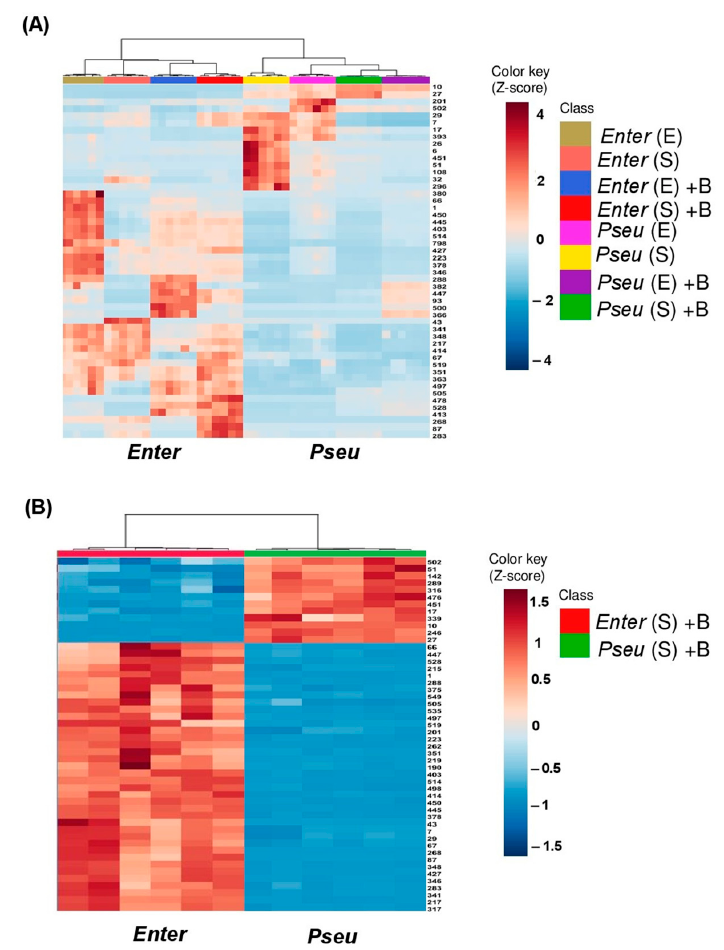
Figure 6. Heat map describing the distribution of the top 50 more discriminant metabolites, between BPMP-PU-28 ( Pseudomonas urmiensis ) and BPMP-EL-40 ( Enterobacter ludwigii ), according to culture conditions and growth stages. Pseu ( Pseudomonas urmiensis ) and Enter ( Enterobacter ludwigii ) were grown in minimal Hoagland medium supplemented with lactate (2%) (see Figure S5) and buffered (150 mM KH 2 PO 4 /K 2 HPO 4 , pH 6.7) (B) or unbuffered (U). Aliquots of culture supernatant were collected during the exponential and stationary phases (E and S, respectively; see arrows in Figure S5) and analyzed by LC-MS/MS. The heat map was generated by MetaboAnalyst 5.0 28 (https:// www.metaboanalyst.ca/MetaboAnalyst/ModuleView.xhtml) accessed on 15 January 2021). ( A ) Top 50 more discriminant metabolites between BPMP-PU-28 and BPMP-EL-40 . Numbers on the right refer to the metabolites, which are listed in Table S2. ( B ) Discriminant metabolites identified in the bacterial growth media (buffered and collected during the stationary phase) are shown to affect root system and root hair development in Figures 3 and 4. Numbers on the right: see Table